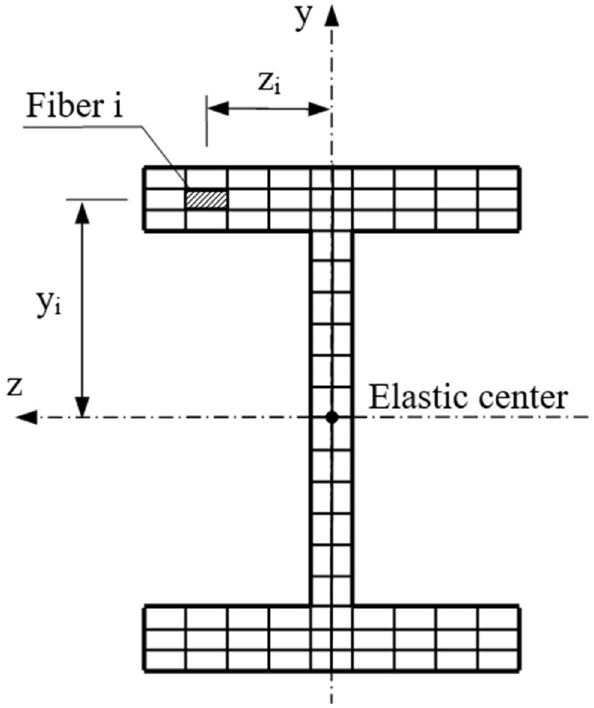
Fig. 1 Discretion of